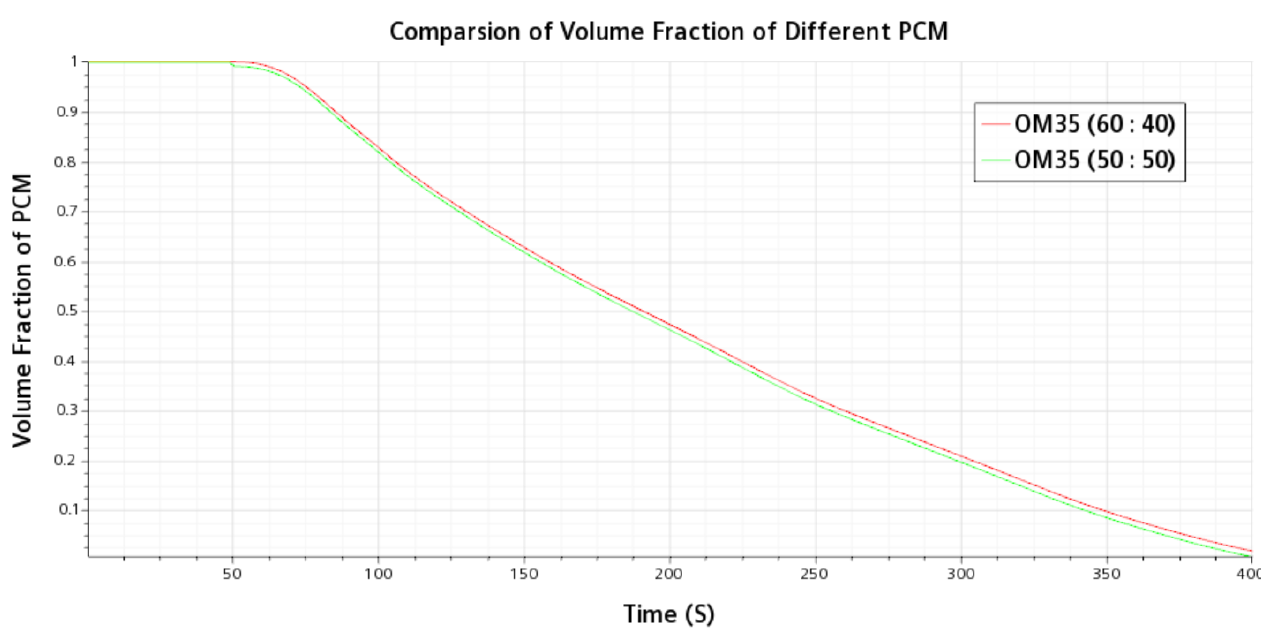
Figure 18. Comparison of volume change with function of time for different PCM materials.